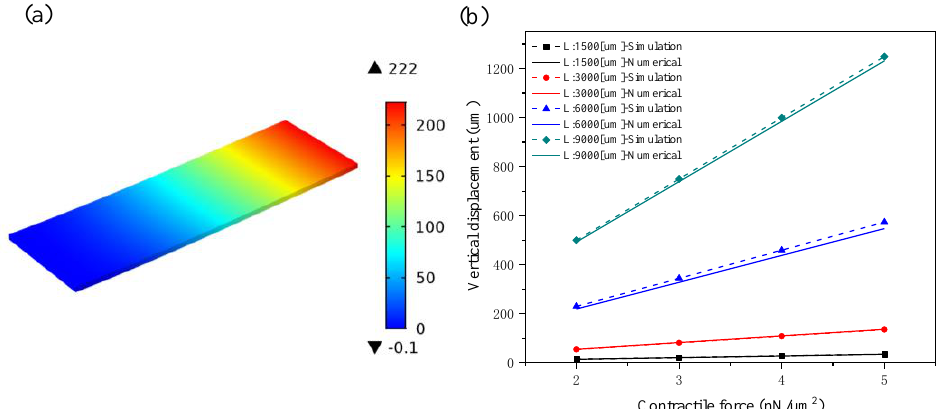
Figure 2. The numerical and simulation results of the maximum displacements at the free end of the plain microcantilever under different conditions (contractile force: 2~5 nN/μm 2 ): ( a ) vertical displacement plot of the plain microcantilever (the microcantilever lengths are 1500, 3000, 6000, and 9000 μm, respectively) when the contractile force is 2 nN/μm 2 ; ( b ) the effect of contractile force on the maximum displacements of the plain microcantilever with different sizes (the microcantilever lengths are 1500, 3000, 6000, and 9000 μm, respectively; the aspect ratio is 3:1; and thickness is 100 µm).